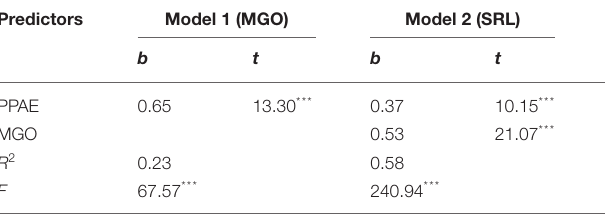
TABLE 2 | The mediation effect of mastery goal orientation. Predictors